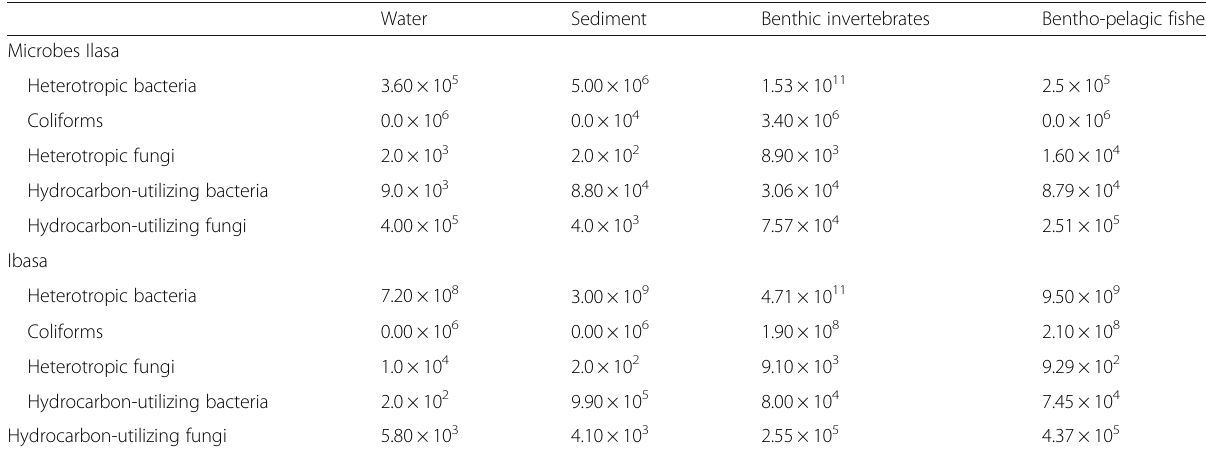
Table 7 Microbial population distribution sediments, water and aquatic organisms in Ibasa and Ilase study areas, Snake Island, Lagos, Ilase